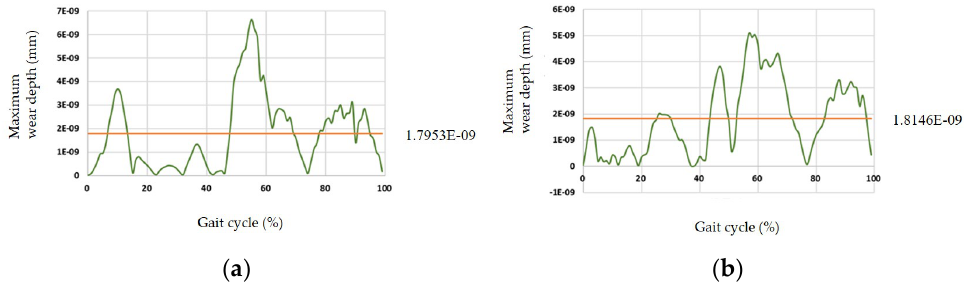
Figure 14. Comparison of maximum wear depth after 5,000,000 cycles in two gait mechanisms: ( a ) Normal gait mechanism; ( b ) Flatback gait mechanism.